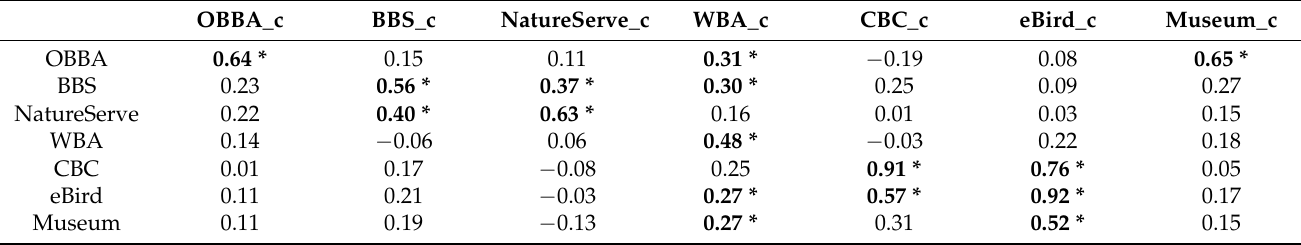
Table 5. Spearman rank correlation matrix for the number of birds of conservation concern detected (column names) and the total detected by each method (shown by row names and denoted with the suffix ‘_c’). Correlation coefficients ( r ) are shown and significant correlations ( p < 0.05) are in bold with an asterisk